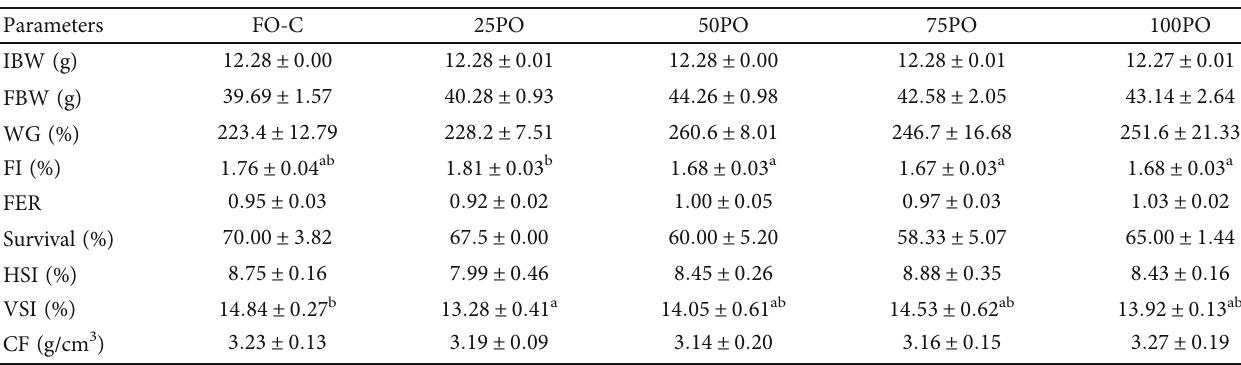
Table 5: Proximate composition of whole body, muscle, and liver of experimental tiger pu ff er (% wet weight, mean ± standard error ). Parameters FO-C Whole body Crude protein (% w.w.)